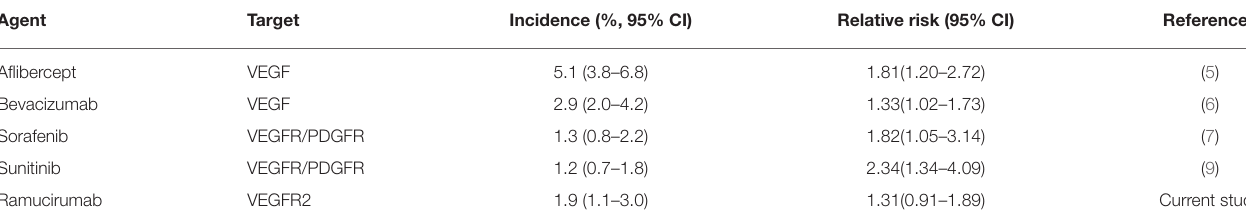
TABLE 3 | Overall incidence and relative risk of fatal adverse events in patients treated with anti-angiogenic